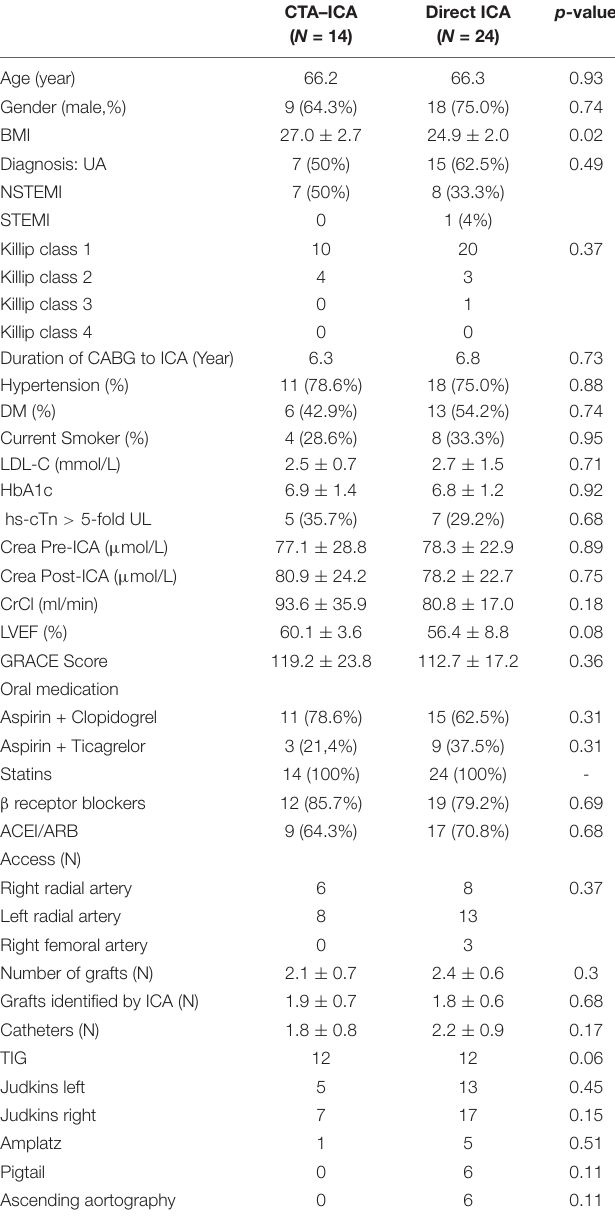
TABLE 1 | Patients characteristics in the CTA–ICA and direct ICA groups.